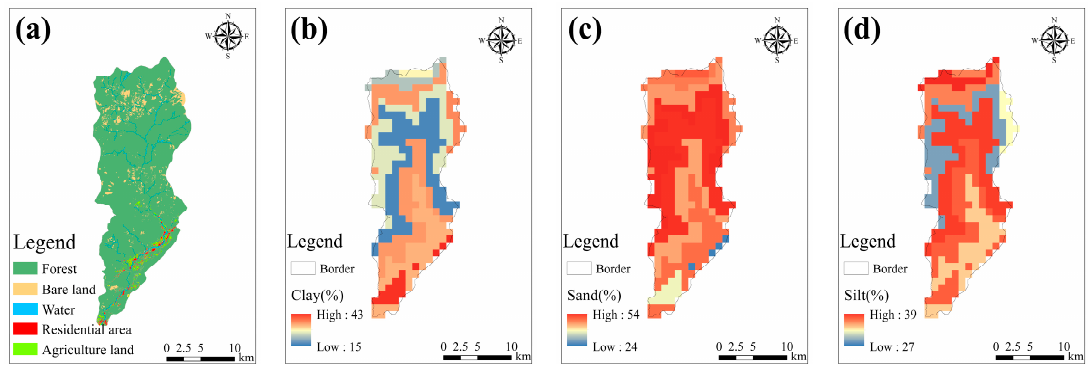
Figure 2. Land use and soil type in the study area: land use ( a ), clay ( b ), sand ( c ), and silt ( d ).